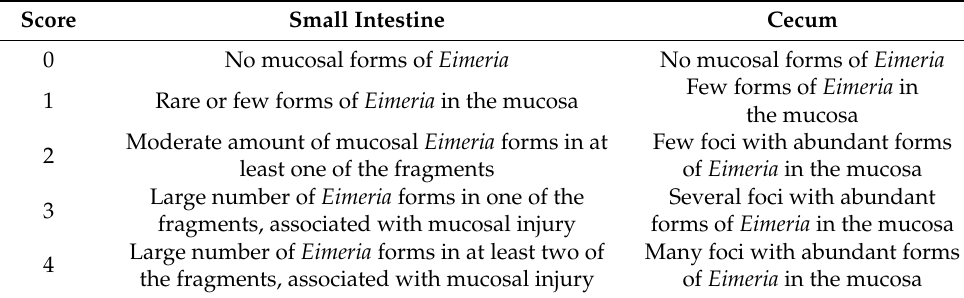
Table 1. Lesions scores from Eimeria spp. infection for histological